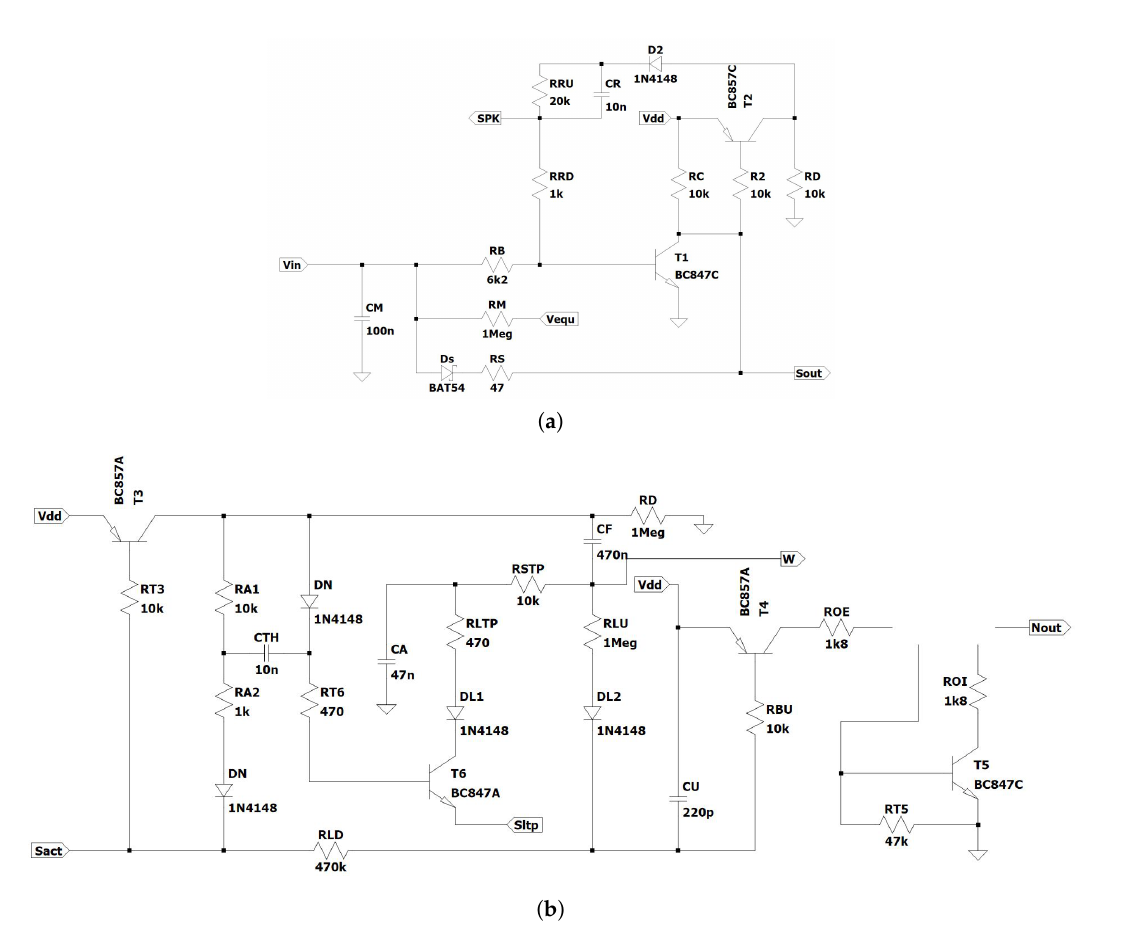
Figure A1. The schematic of ( a ) the electronic SOMA and ( b ) the electronic synapse